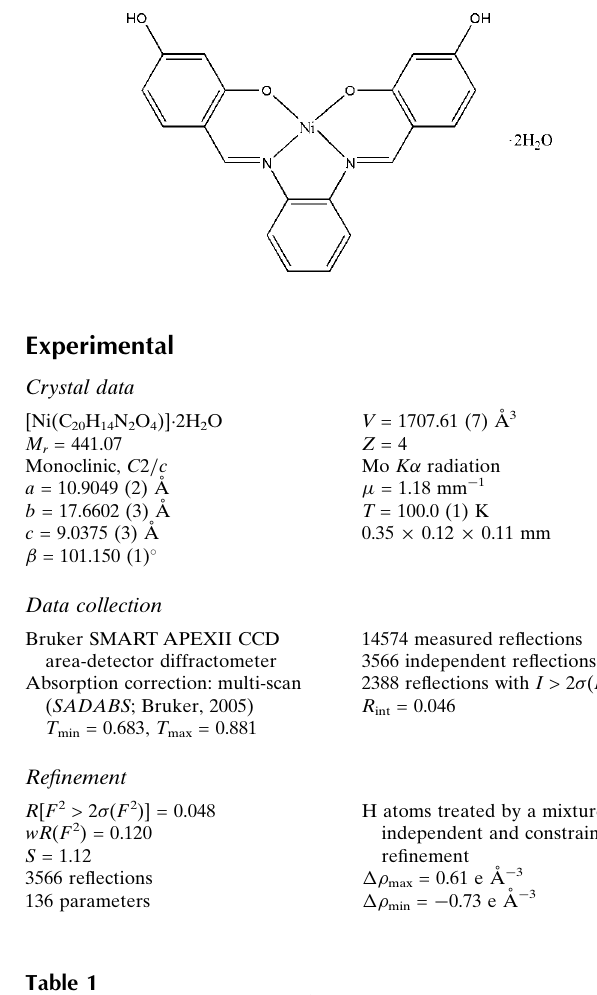
Selected interatomic distances (A˚ ).